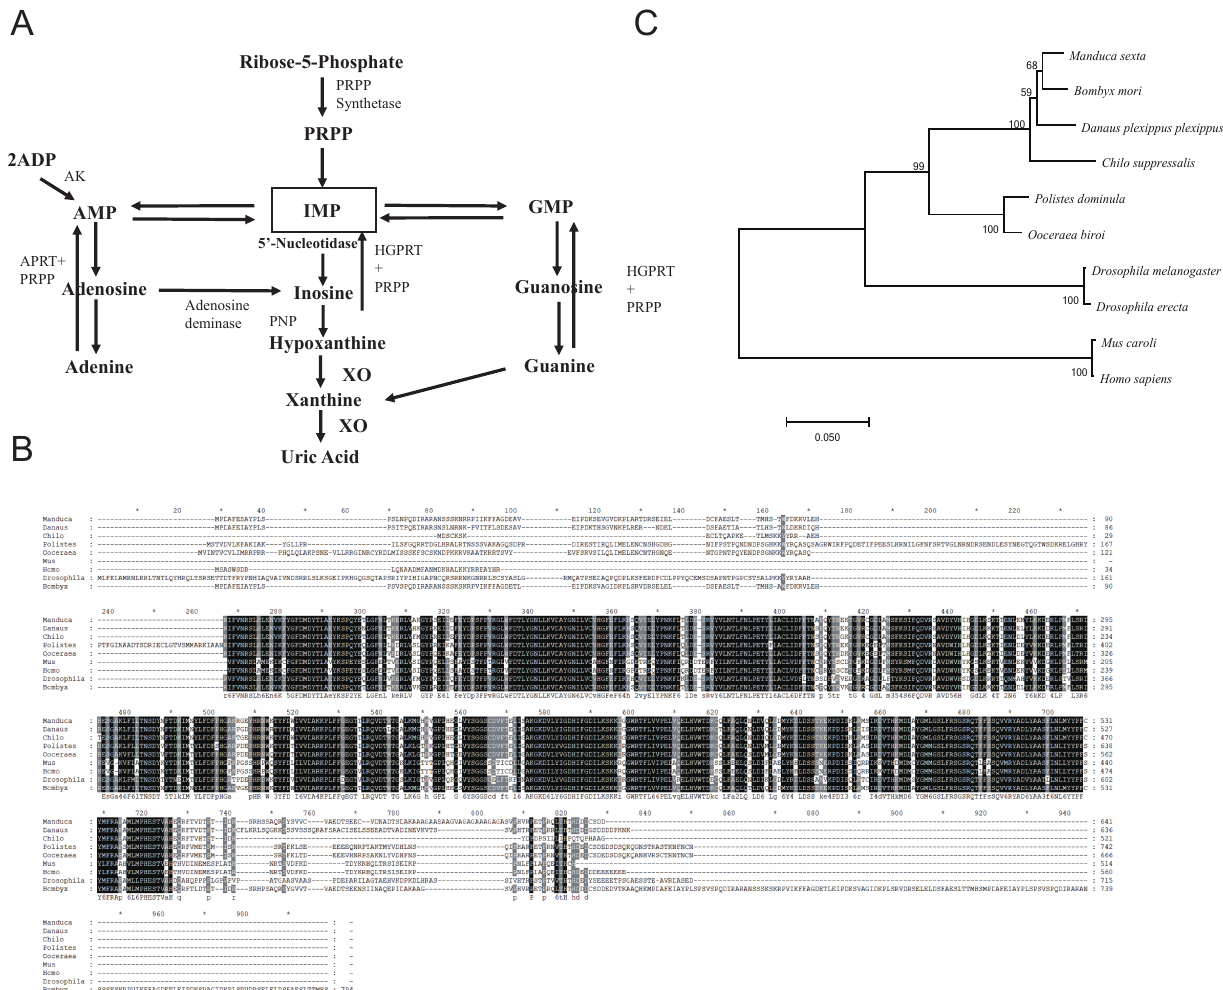
Figure 1. Uric acid metabolism pathway genes in human and silkworm. ( A ) The uric acid metabolism pathway in humans. ( B ) Phylogenetic tree of 5 (cid:48) N proteins. ( C ) Alignment of 5 (cid:48) N